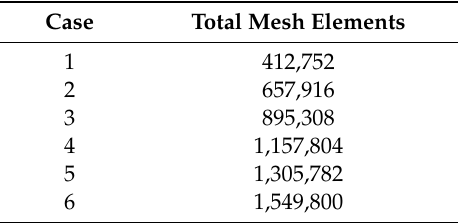
Figure 5. Static pressure under the six cases of total mesh elements. Table 2. Cases of mesh